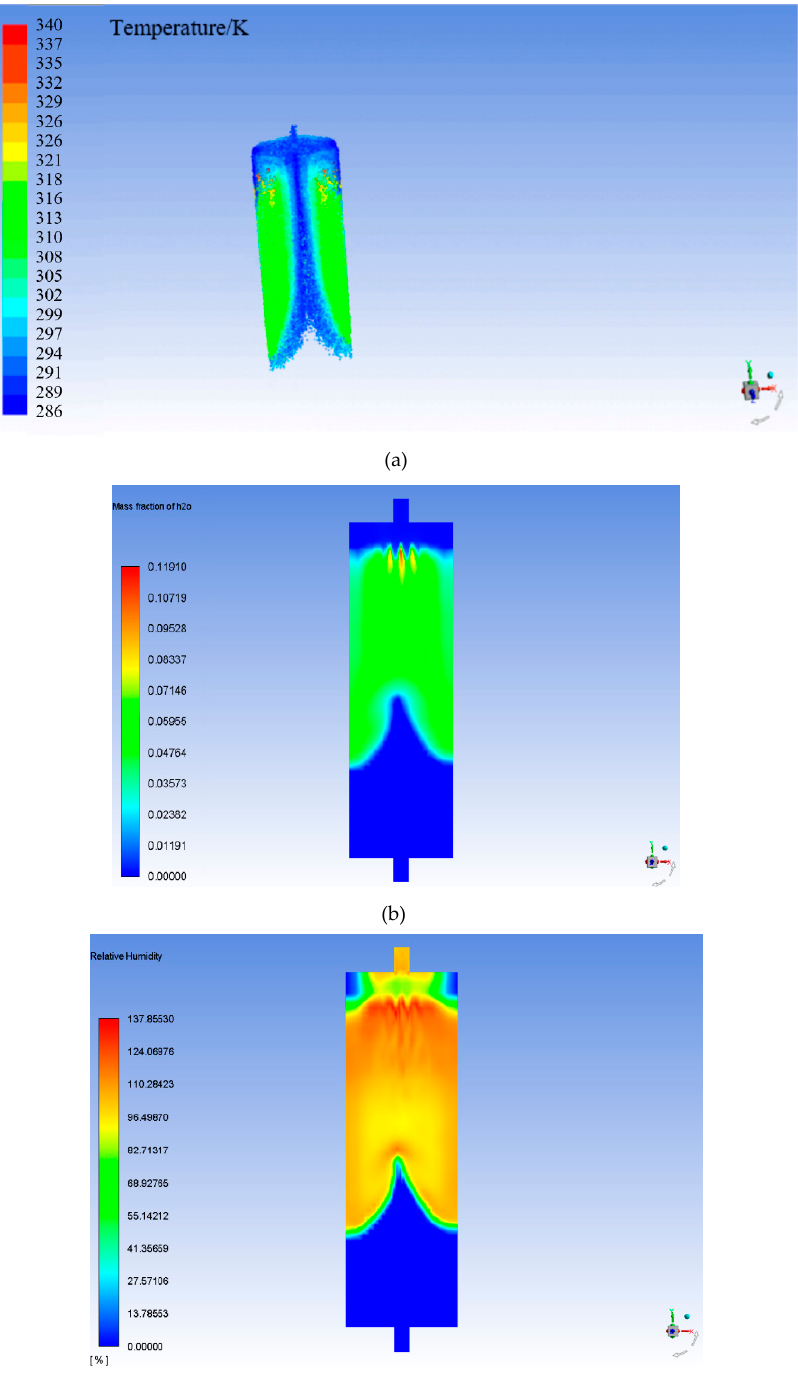
Figure 7. Verification of humidification performance of the 10 kW humidifier: ( a ) The temperature distribution of nine atomizing nozzle models; ( b ) water vapor mass fraction at the outlet of the humidifier; ( c ) relative humidity at the outlet of the humidifier.